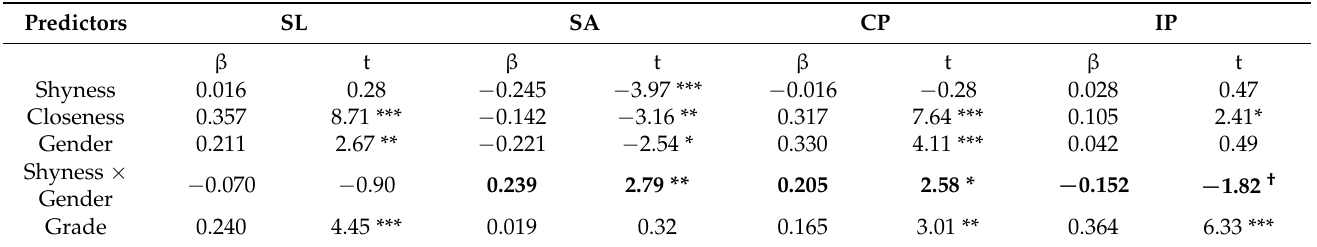
Table 5. Main and moderating effects of shyness and gender on indices of school engagement.